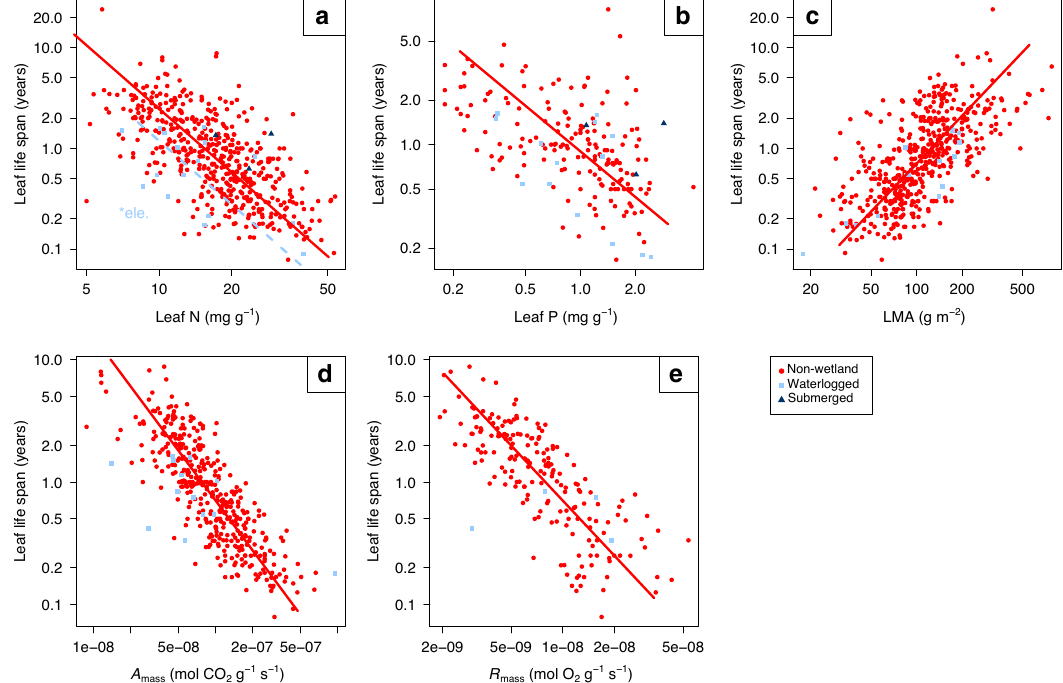
Fig. 3 The bivariate relationships with leaf life span. a Leaf life span vs. leaf nitrogen (leaf N). b Leaf life span vs. leaf phosphorus (leaf P). c Leaf life span vs. leaf dry mass per unit area (LMA). d Leaf life span vs. photosynthetic rate ( A mass ). e Leaf life span vs. dark respiration rate ( R mass ). The waterlogged and submerged wetland plants are shown in light blue squares and dark blue triangles, respectively. The non-wetland plant data from GLOPNET 3 are shown in red circles with a solid red line. The dashed light blue line with the notation of *ele . identi fi es signi fi cant elevation differences among parallel slopes respectively. Note that graph axes are log 10 scaled and the absence of leaf life span data coupled to LMA, A mass , or R mass for submerged